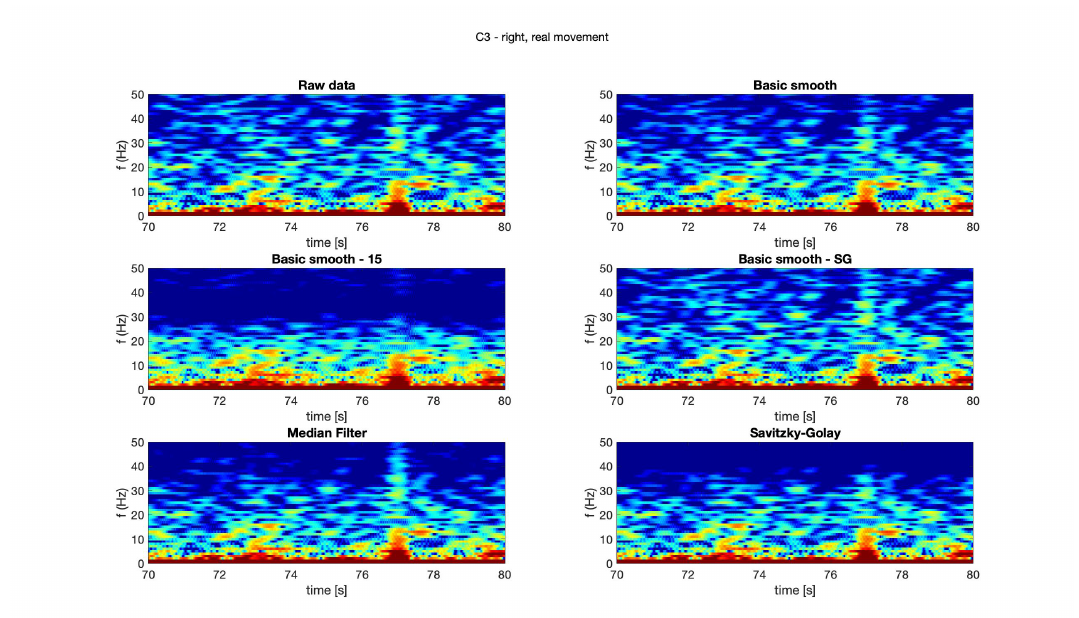
Figure 4. Spectrogram—C3, right hand, real